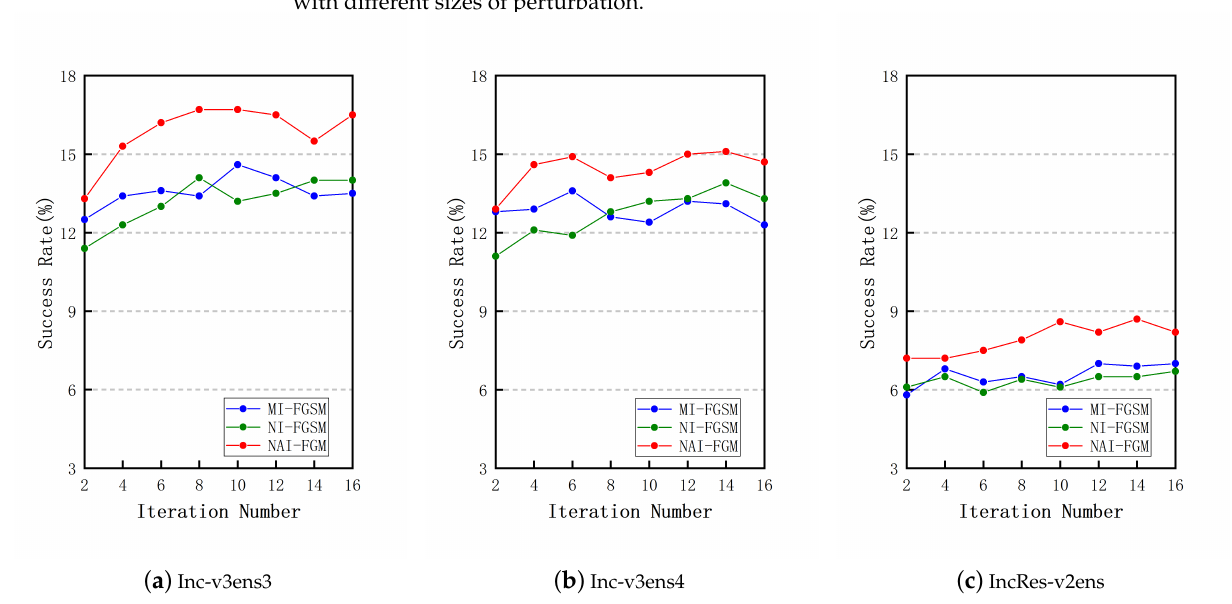
Figure 6. Attack success rates (%) of NAI-FGM, MI-FGSM and NI-FGSM on three adversarially trained networks with Inc-v3 as the origin model with different number of